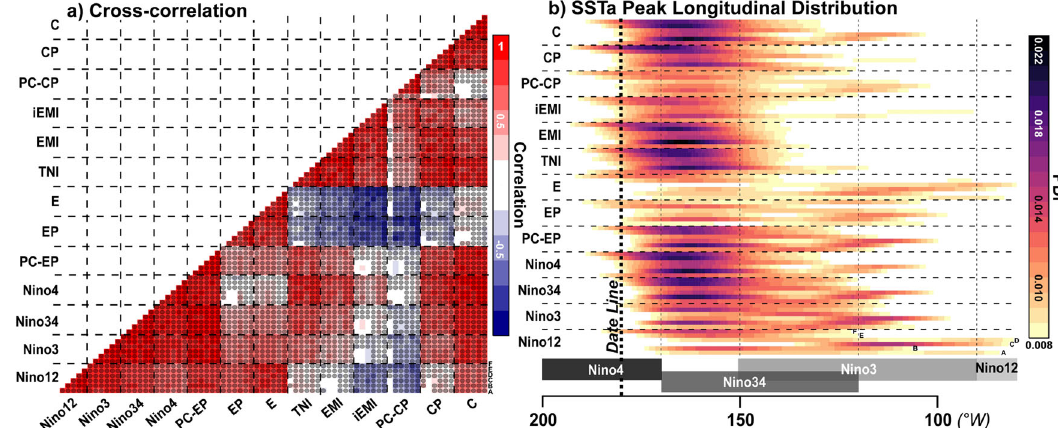
Fig. 1 Relationships between ENSO indices, and their ability to disentangle CP and EP. a Pearson ’ s correlations between 13 ENSO indices (Niño boxes; 38 PC-based EP- and CP-ENSO; TNI; 40 EMI and iEMI; 41 EP and CP; 32 E and C 39 ). Black shaded dots indicate signi fi cant correlations at p = 0.05, using 1000 phase randomisations to account for serial correlations. b Probability density function (PDF) of the locations of SSTa peaks over the equatorial Paci fi c (5°S – 5°N; − 210 to − 60°W), when each ENSO index exceeds ±0.5 °C standard deviation. For each index, each row/column corresponds to a different observational, reanalysis or satellite-derived dataset (A – F: ERSST.v5, COBESST.v2, HadSST1, SODA.si3, OISST.v2, CERA20C). Correlations are calculated over their respective common periods (1870 – 2018 when using observations only, 1870 – 2015 when using SODA.si3, 1901 – 2010 when using CERA20C, and 1981 – 2018 when using OISST.v2). Locations of Niño boxes, as well as of the date line, are